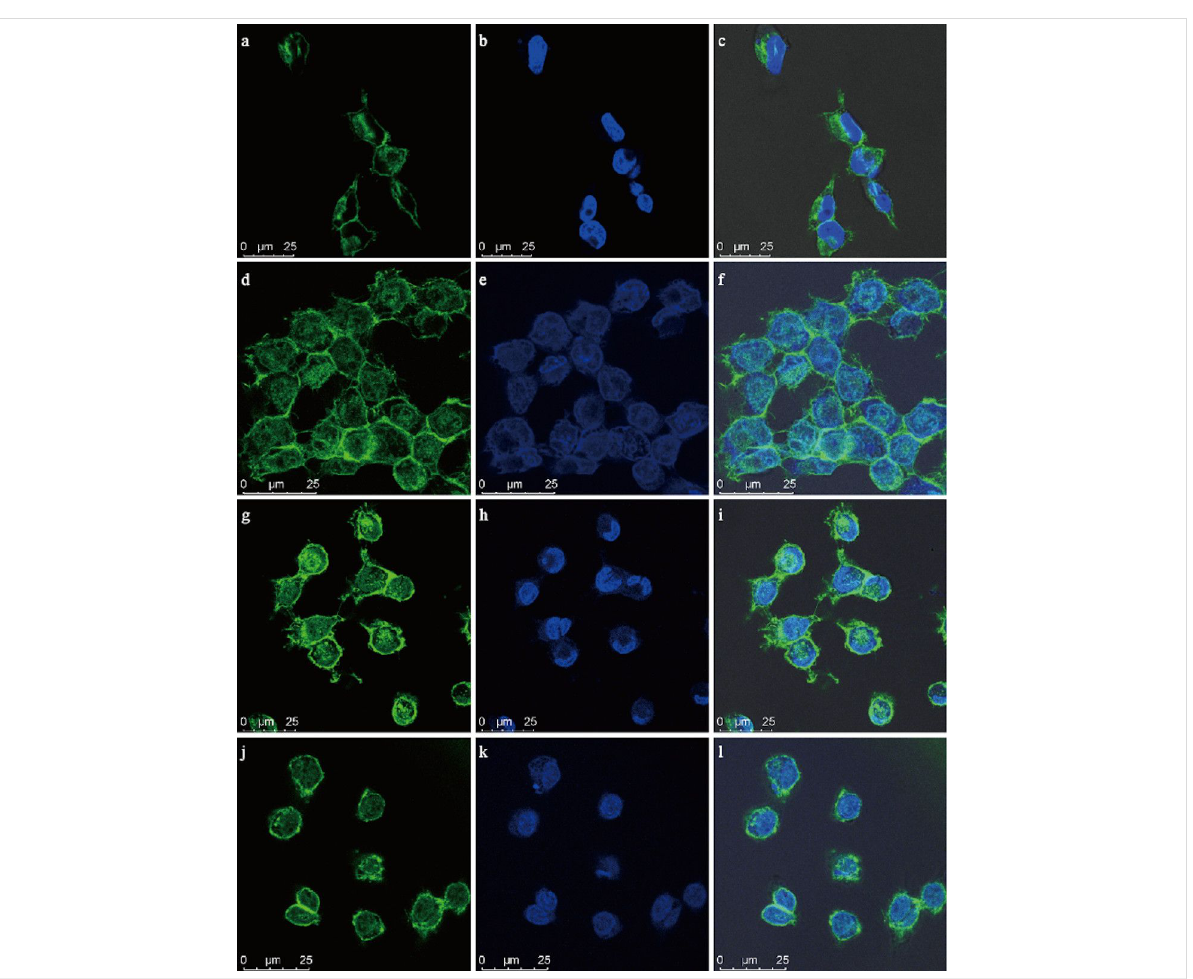
Figure 5: Laser confocal fluorescence images of MIA PaCa-2 before and after DOX treatment. (a–c) Without DOX treatment; (d–f) treated with 10 µg/mL DOX; (g–i) treated with 30 µg/mL DOX; (j–l) treated with 50 µg/mL DOX. Cells were stained for nuclei (blue) and cytoskeleton (green).